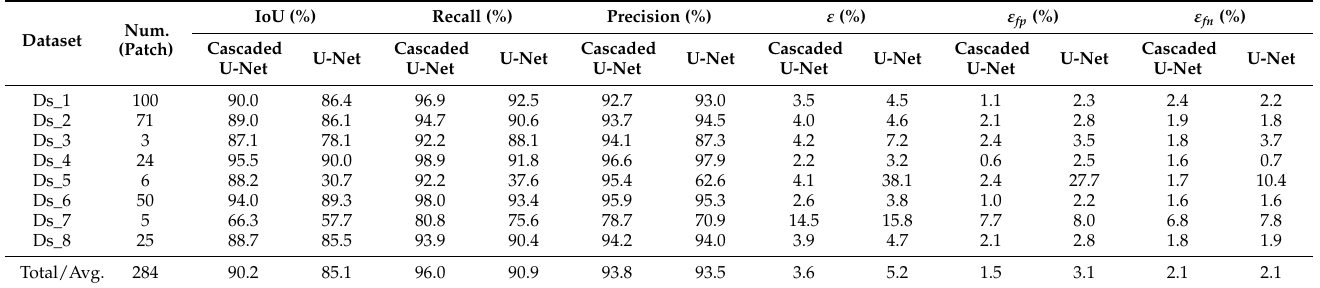
Table 4. Comparison of six indicators between U-Net and our model on the eight different types of scraping patch testing dataset.